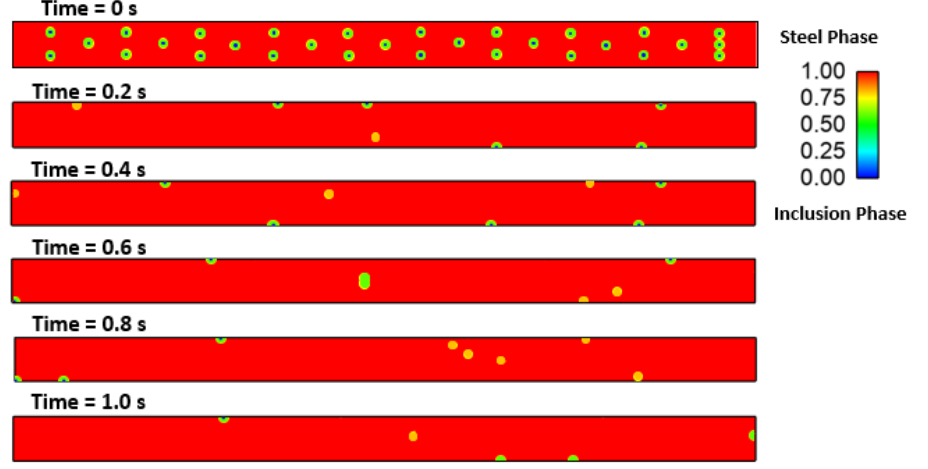
Figure 8. 4.30: Motion of alumina inclusion during solidification (initial temp: 1893 K, sulfur: 70 PPM).